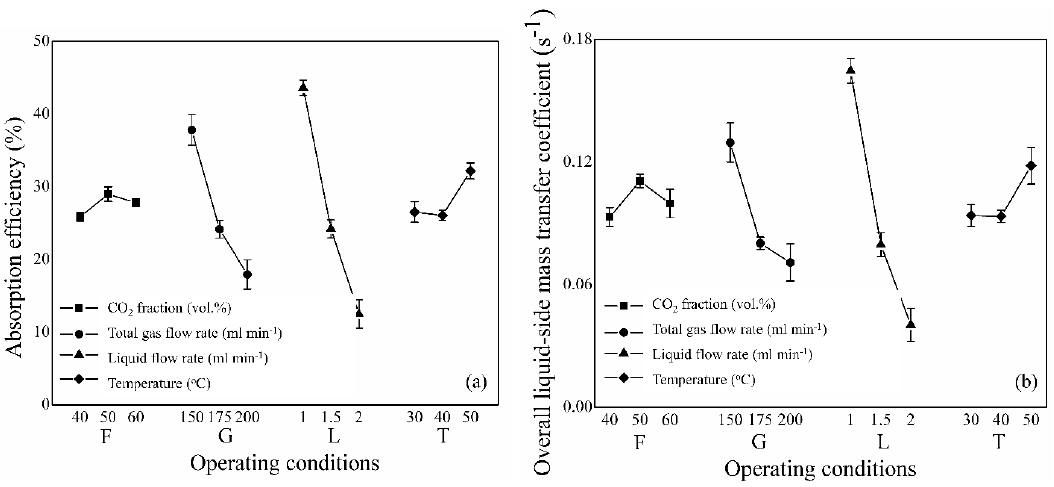
Main e ff ect of absorption variables on the responses; ( a ) absorption e ffi ciency, Figure 2. Main effect of absorption variables on the responses; ( a ) absorption efficiency, ( b ) overall ( b ) overall liquid-side mass transfer coe ffi cient. Energies 2020 , 13 , x FOR PEER REVIEW liquid-side mass transfer coefficient.